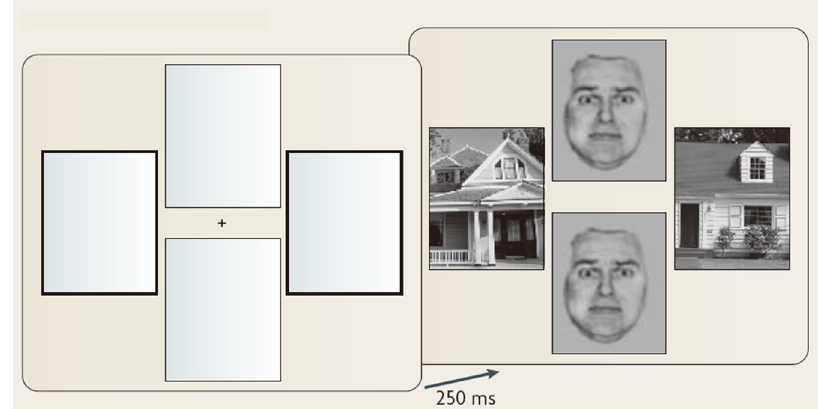
Figure 5. Experimental paradigm. The first display presents 4 empty frames in vertically and horizontally paired positions, with either the 2 horizontal or the 2 vertical frames being highlighted. The next display shows a central fixation point followed by paired faces and paired houses arranged in vertical or horizontal positions. The 2 highlighted frames always predict the locations of the paired houses. Both faces had either neutral or fearful expressions. The positions of the paired faces or houses (vertical or horizontal) and the facial expressions (neutral or fearful) were counterbalanced across subjects and were presented in a random order. The figure is reprinted with permission from the ref. 55 (2010) © Macmillan Publishers Ltd., in Nature Publishing Group. The figure is a modified version of the original figure from the ref. 54 (2001) © Cell